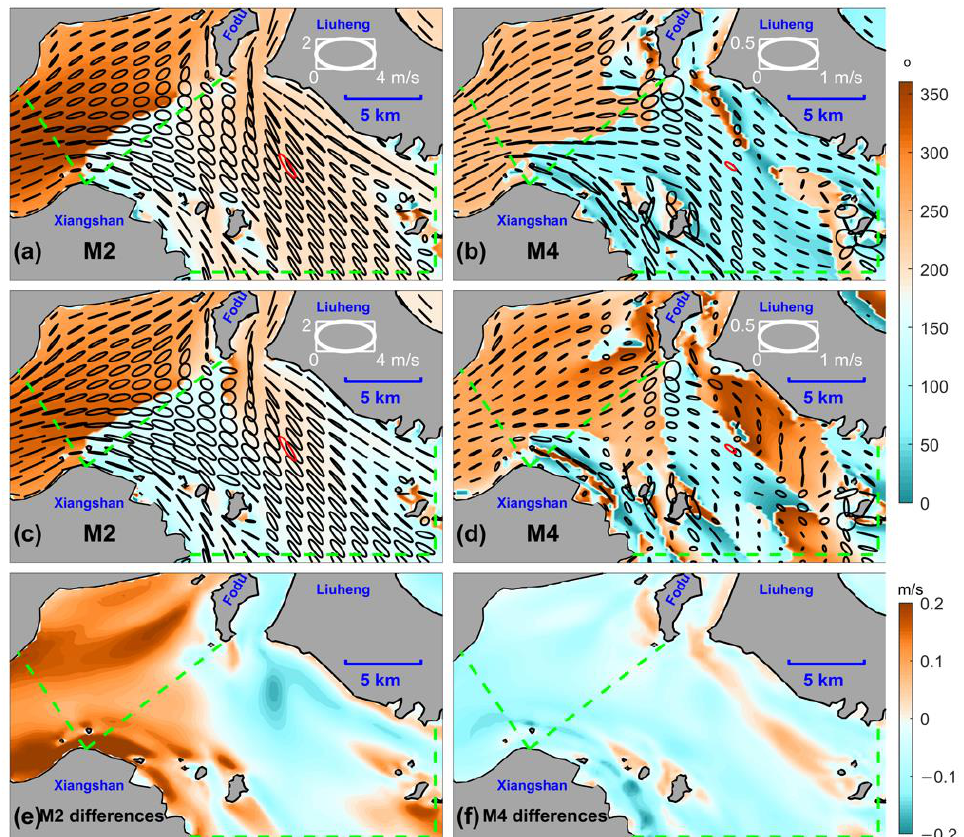
Figure 10. Distributions of vertical-averaged tidal current ellipses (black ellipses, in m/s) and phases (contour plots, in °) that were obtained by ( a , b ) Case3 and ( c , d ) Case0 models. The red ellipses were obtained by ADCP data. The tidal constituents are presented in the bottom left of each panel. The scale of tidal current ellipses of M2 and M4 are plotted in the upper-right corner of each panel. The distributions of amplitude differences for ( e ) M2 and ( f ) M4 between Case3 and Case0 (in m/s). Positive values indicate Case0 >